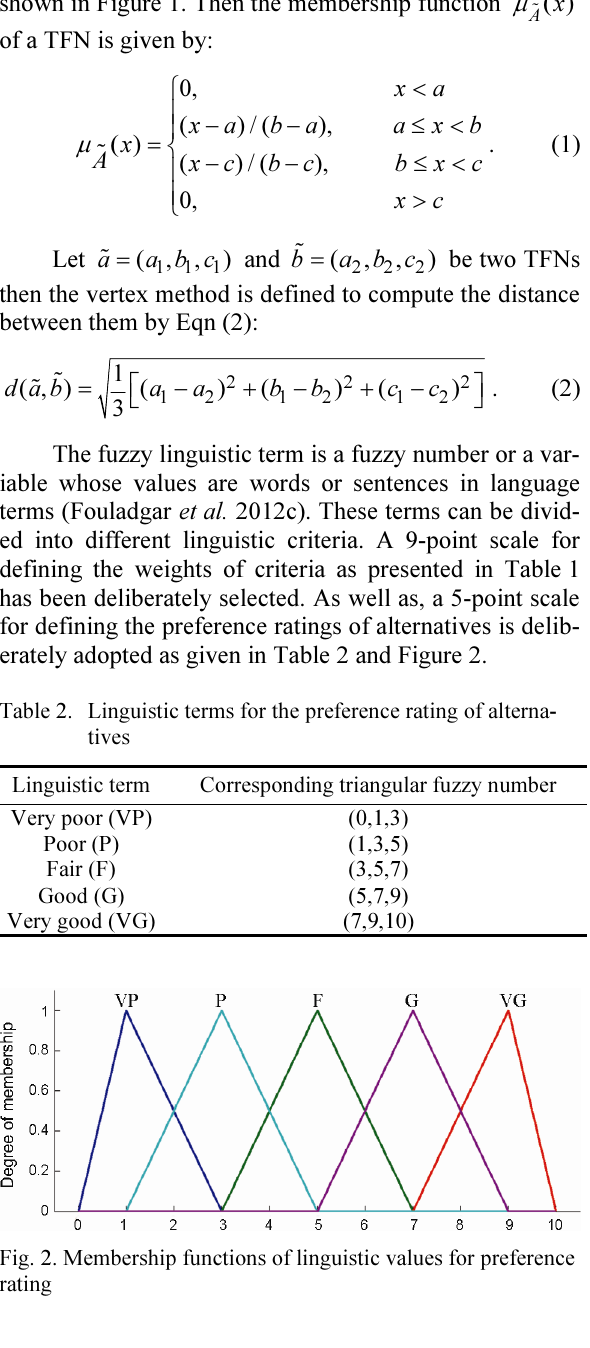
Table 1. Linguistic terms for the importance weights of the criteria Linguistic term Fuzzy number Triangular fuzzy